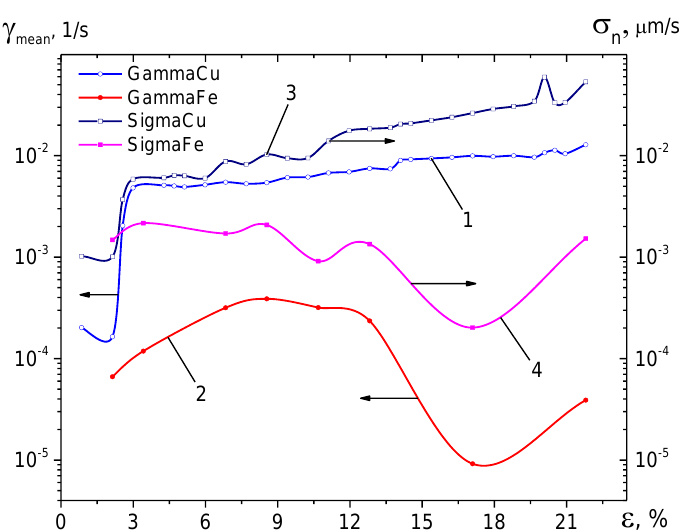
Figure 18. Evolution of the average strain rate γ mean in the regions of development of necks in copper (1) and steel (2) and the corresponding standard deviations for copper (3) and steel (4). It is seen that the deformation rate of copper is 2–3 orders of magnitude higher than that of steel, since copper has a significantly higher ductility. From the moment the sample enters the loading mode ( ε > 2%), the strain rate is 5 × 10 − 3 1/s, it increases exponentially and reaches the value 10 × 10 − 3 1/s by the moment of